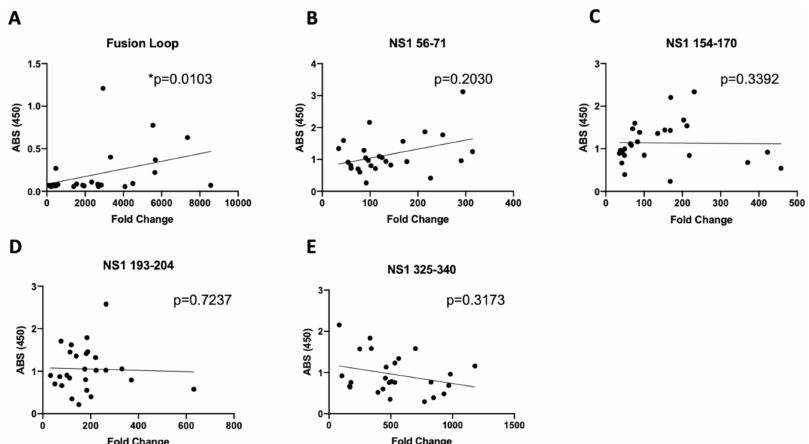
Figure 6. Correlation of DSCB fold change and corresponding ELISA readings. ELISA absorbance was compared to the average of the highest fold change values from the DSCB data for ( A ) Fusion loop, ( B ) NS1 56-71, ( C ) NS1 154-170, ( D ) NS1 193-204, and ( E ) NS1 325-340. p -values of correlation were determined using a Spearman correlation test, and linear regression lines are shown.